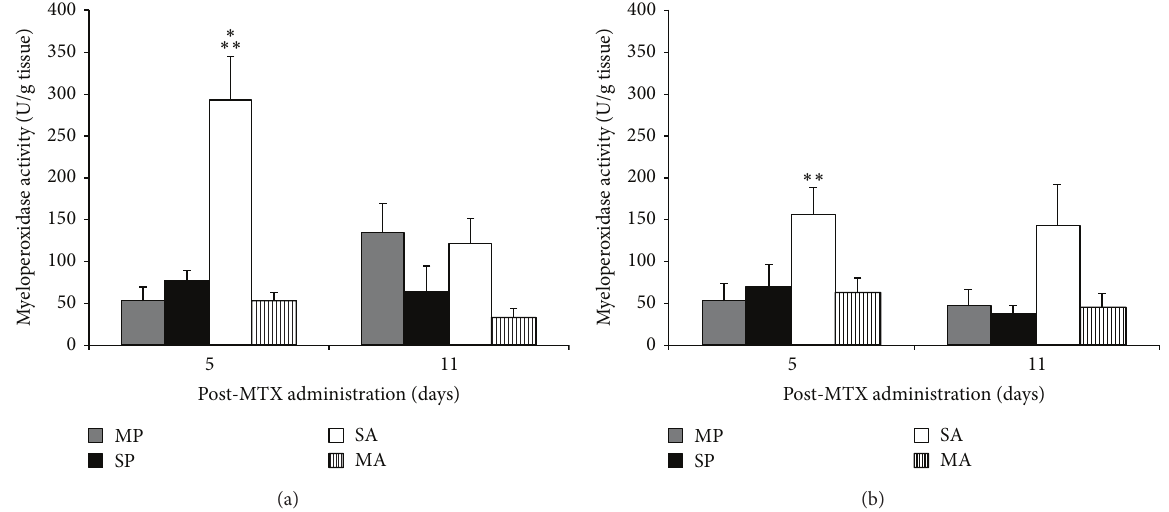
Figure 2: MPO activity (U/g tissue) in the duodenum (a) and jejunum (b) of C57BL/6 mice treated with PS, PM, AS, and MA ( 𝑛 = 8 /group). ∗∗ indicates significant differences ( 𝑃 < 0.01 ) compared to all other groups on d 5. ∗ denotes significance ( 𝑃 < 0.05 ) compared to PM on d 11.